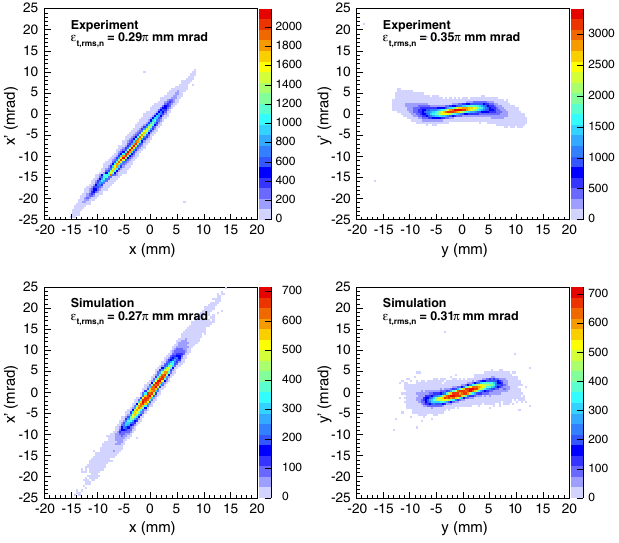
FIG. 7. Measured (upper row) and simulated (lower row) transverse emittances of RFQ III. The absolute positions of the emittance monitors are not fully calibrated.